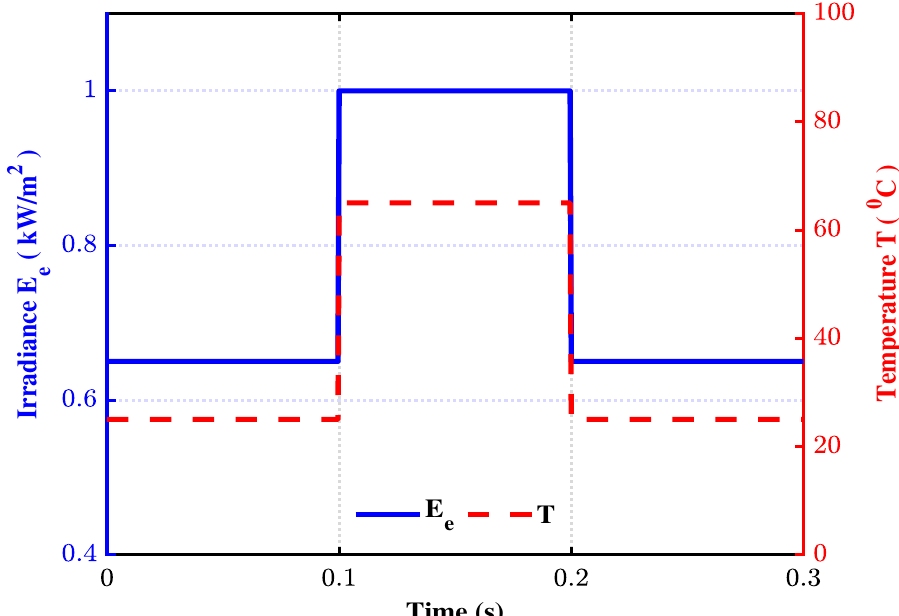
Figure 6. Varying temperature and irradiance